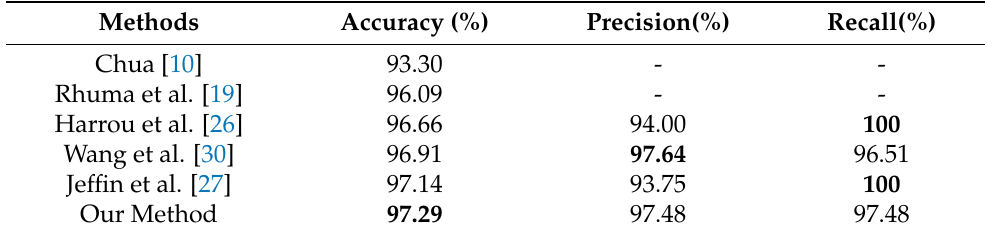
Table 12. Results of fall detection